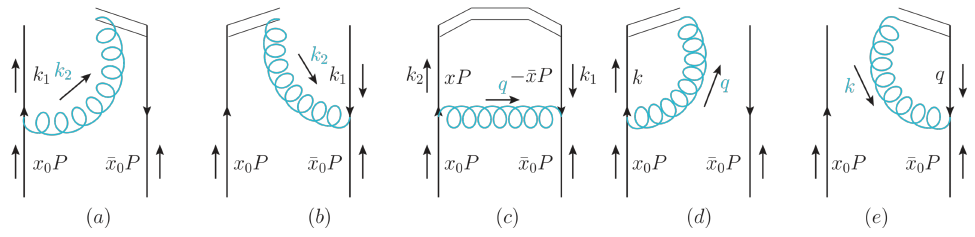
Figure 3 . One-loop diagrams for TMDWFs. The meson state is replaced by a pair of quark and anti-quark. The first and second panels represent the real diagrams, and the third one represents the vertex diagram. The last two are virtual